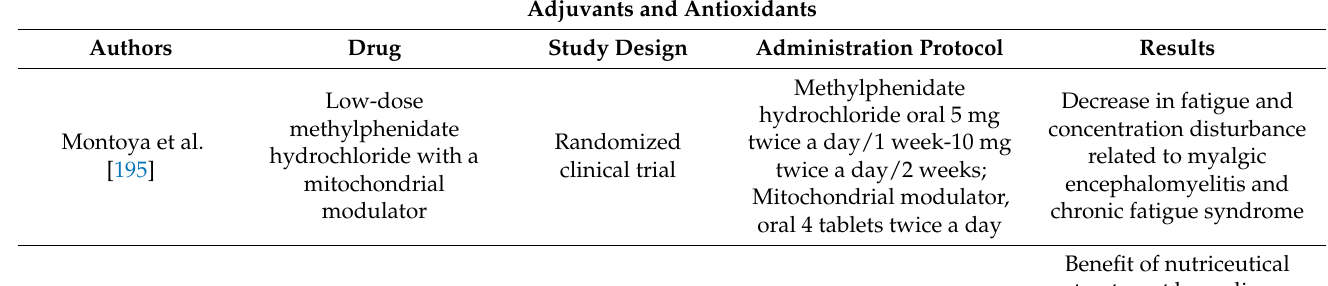
Table 9. Summary of the in vivo studies included about adjuvant and antioxidant treatments for viral infections. Adjuvants and